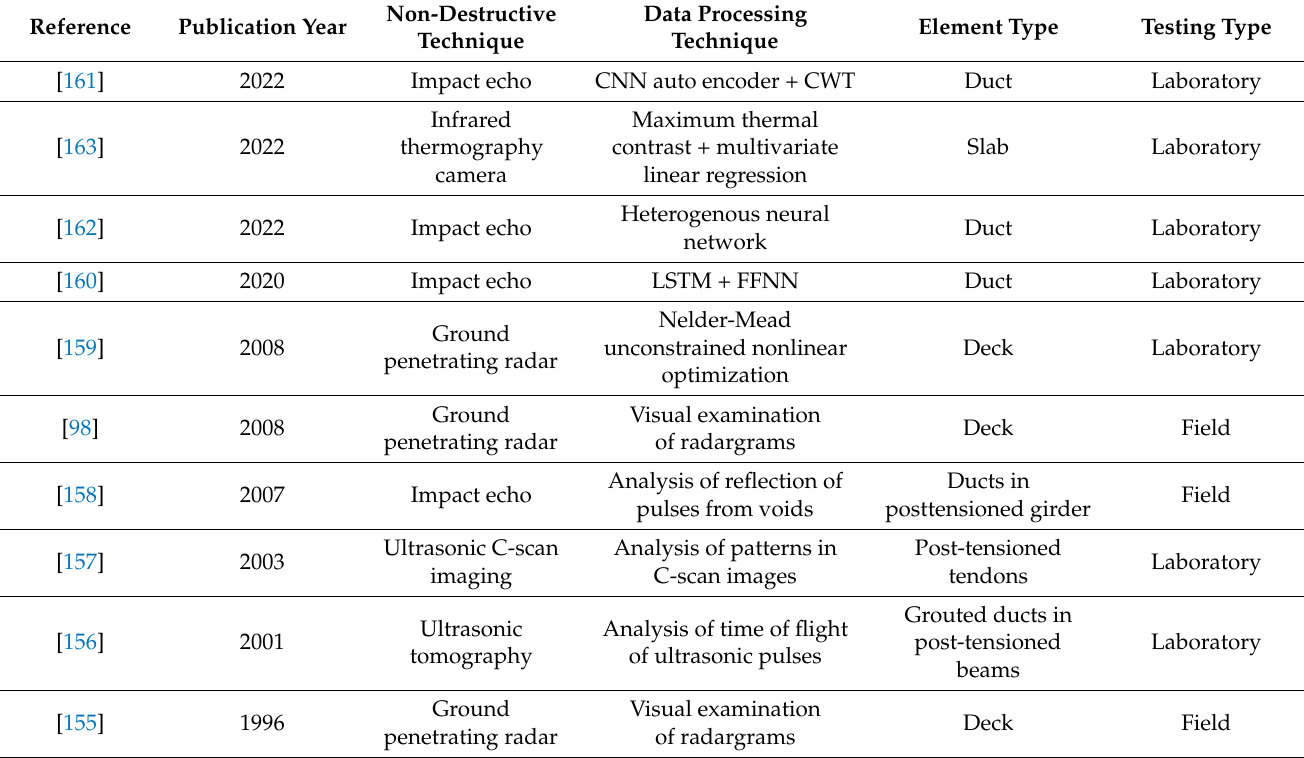
Table 15. Review of some of the research studies on void